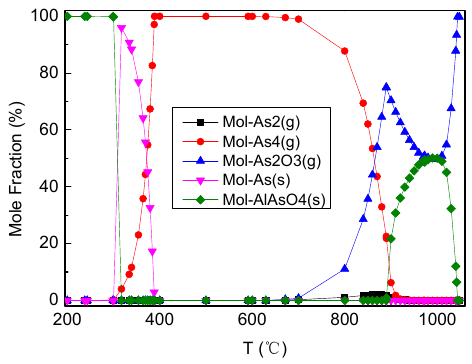
Figure 7. Effect of temperature on arsenic-containing products in dust ash by reduction roasting.